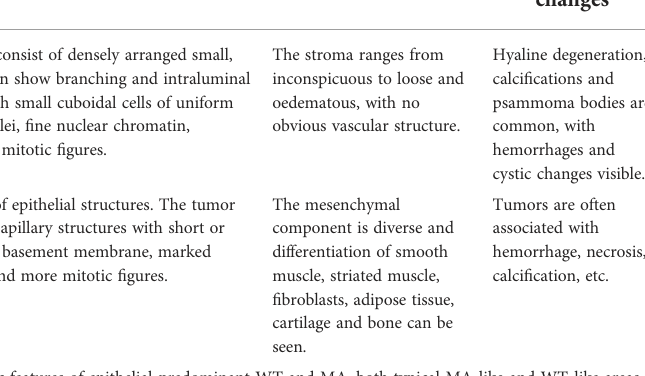
TABLE 2 The histological criteria used to classify tumors into three groups. Border Tumor parenchymal